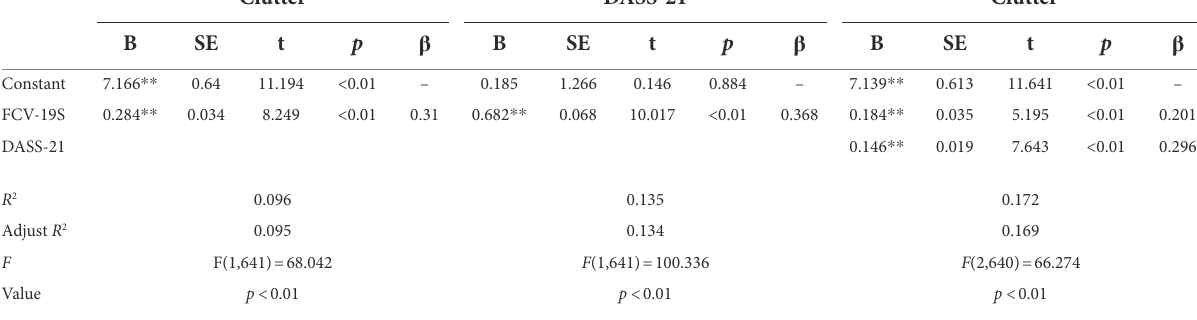
TABLE 4 Results of mediation analysis (clutter).